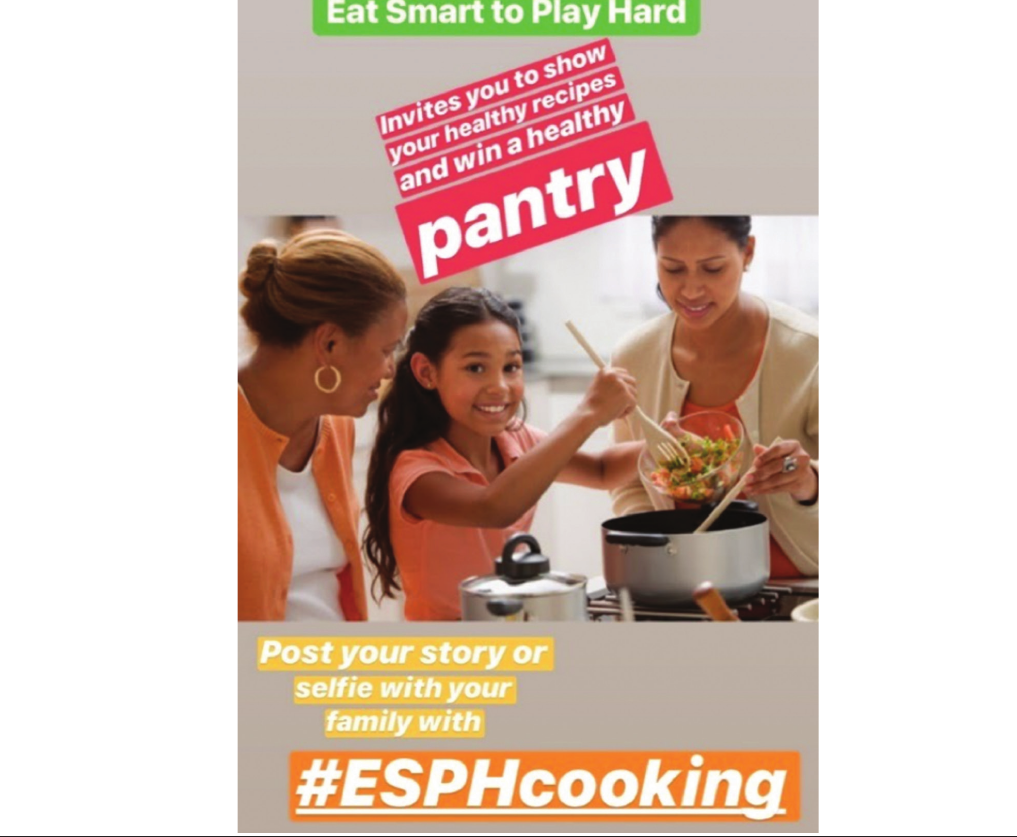
Figure 5. Co-designed strategy artwork for the #ESPHcooking contest (Source: Artwork developed by ESPH